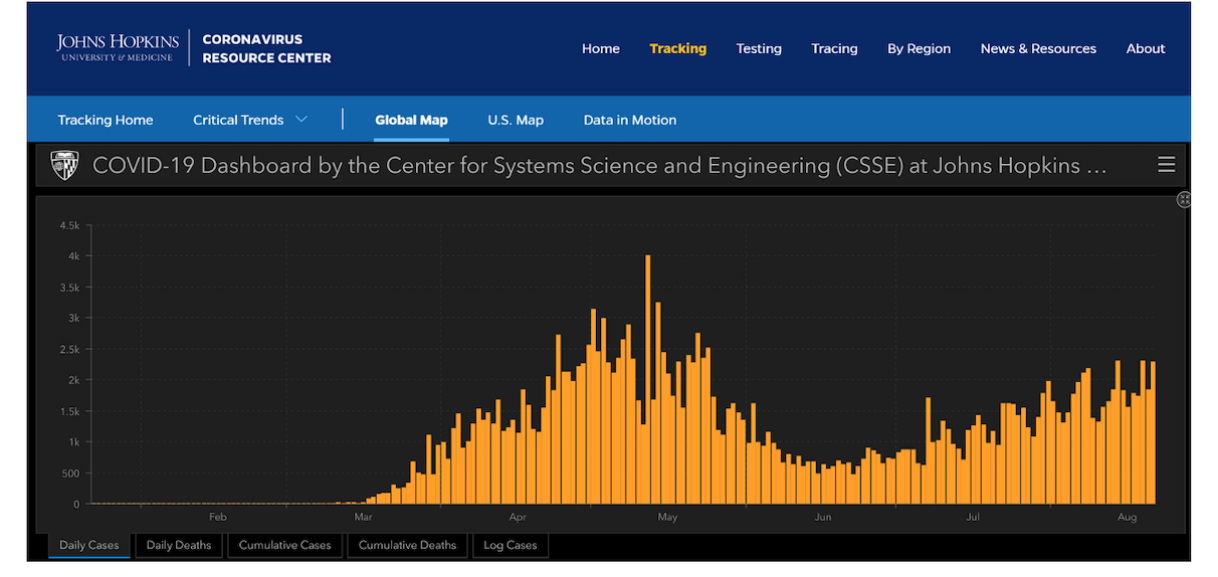
Figure 1. The number of positives per day in Illinois, according to the COVID-19 Dashboard of the Center for Systems Science and Engineering